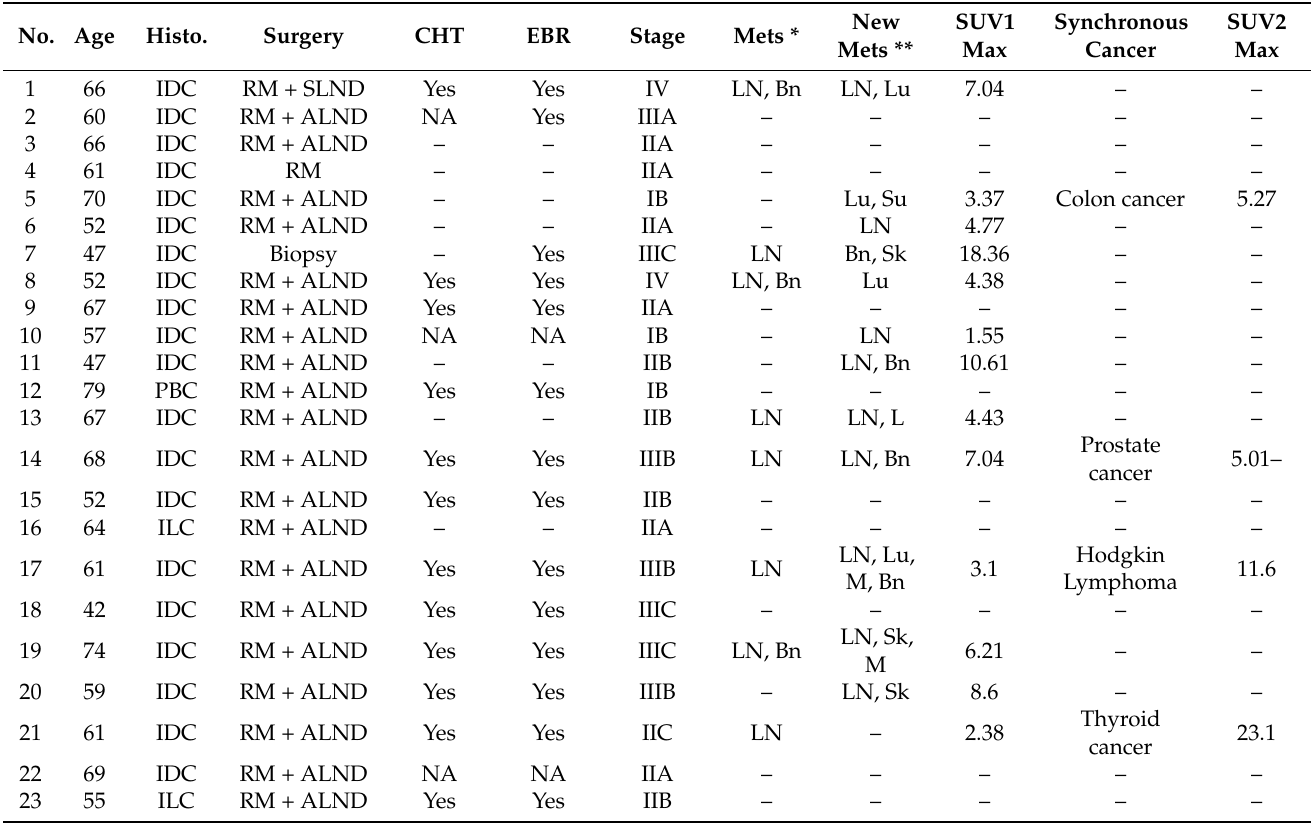
Table 2. The characteristics of patients followed by F18-FDG PET/CT